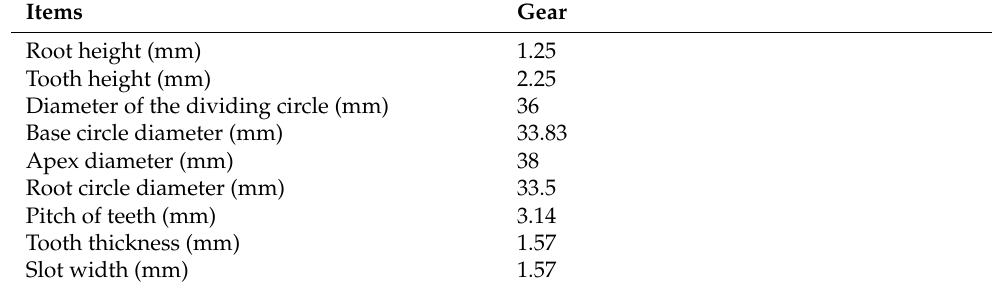
Table 1. Strain gauge sensor parameters.